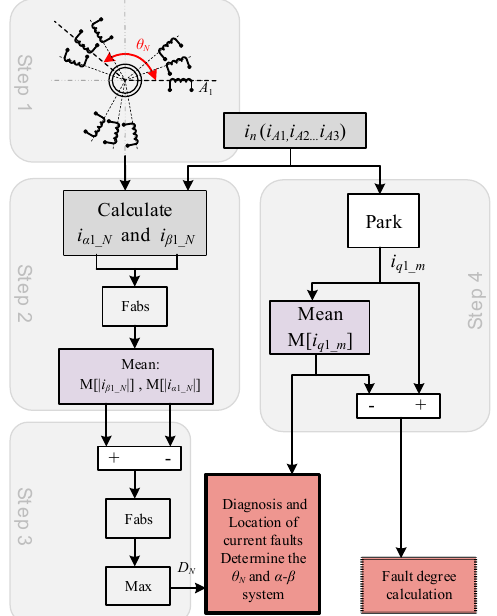
Figure 5. Block diagram of proposed method.